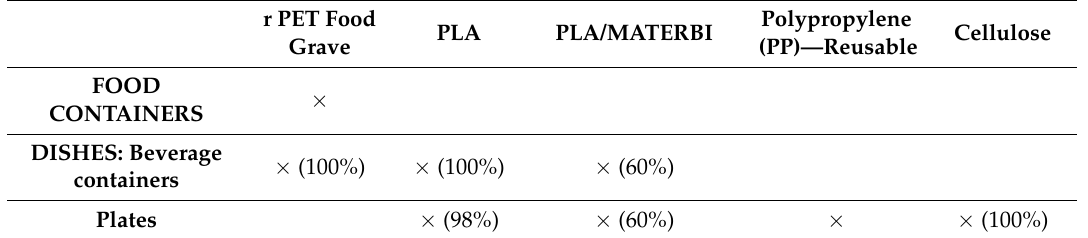
Table 4. ILIP commitment towards SUPs